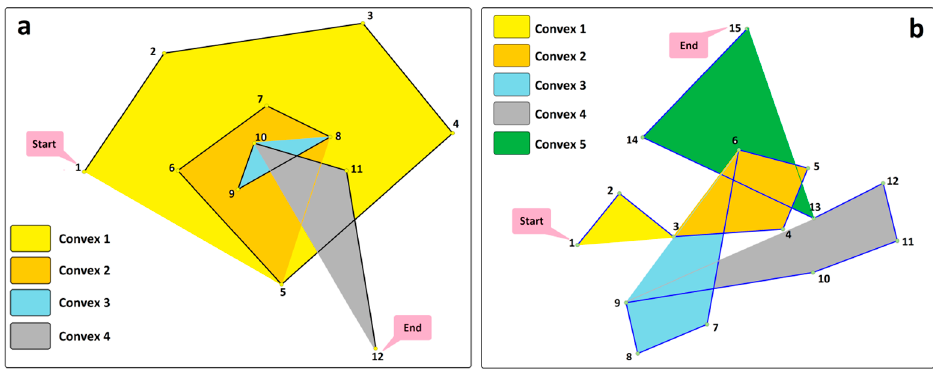
Figure 13. Deriving convex hulls to detect self-intersections in ( a ) simple intersected trajectory and ( b ) more complicated trajectory.